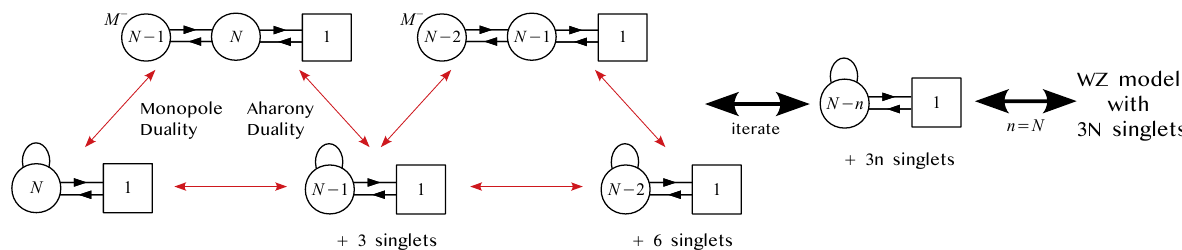
Figure 1 . Derivation of the duality between the U( N ) theory with one adjoint and one (cid:13)avor and the WZ model. We start from an auxiliary quiver theory with gauge group U( N (cid:0) 1) (cid:2) U( N ), where at the U( N (cid:0) 1) node we have the negative fundamental monopole turned on in the superpotential. Applying the monopole duality on the (cid:12)rst node con(cid:12)nes it and yields our original theory. On the other hand, if we apply Aharony duality on the U( N ) node, we con(cid:12)ne it and we go back to the original theory with rank lowered by one unit and 3 extra singlets. Iterating this procedure N times, we get the WZ dual